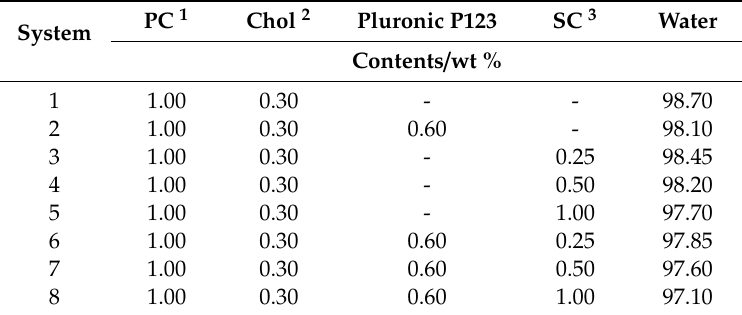
Table 1. Composition of modified